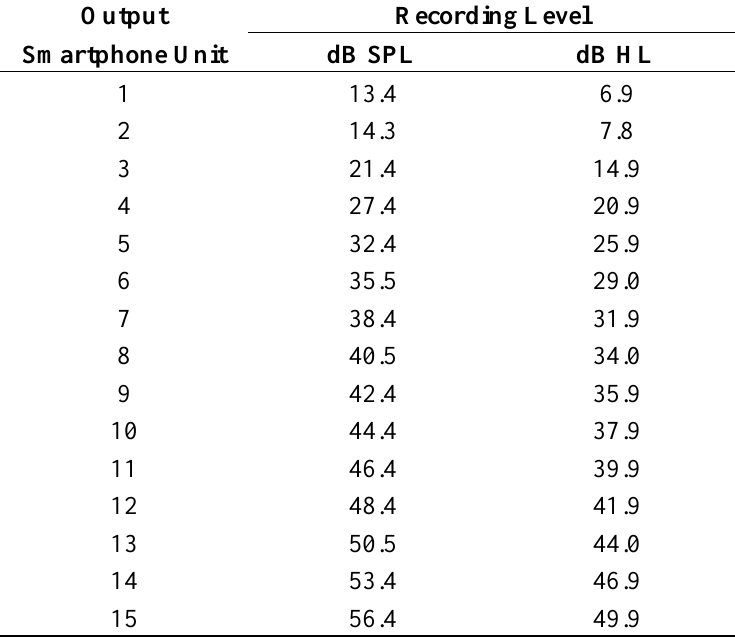
Table 1. Earphone 1000 Hz-output Calibration